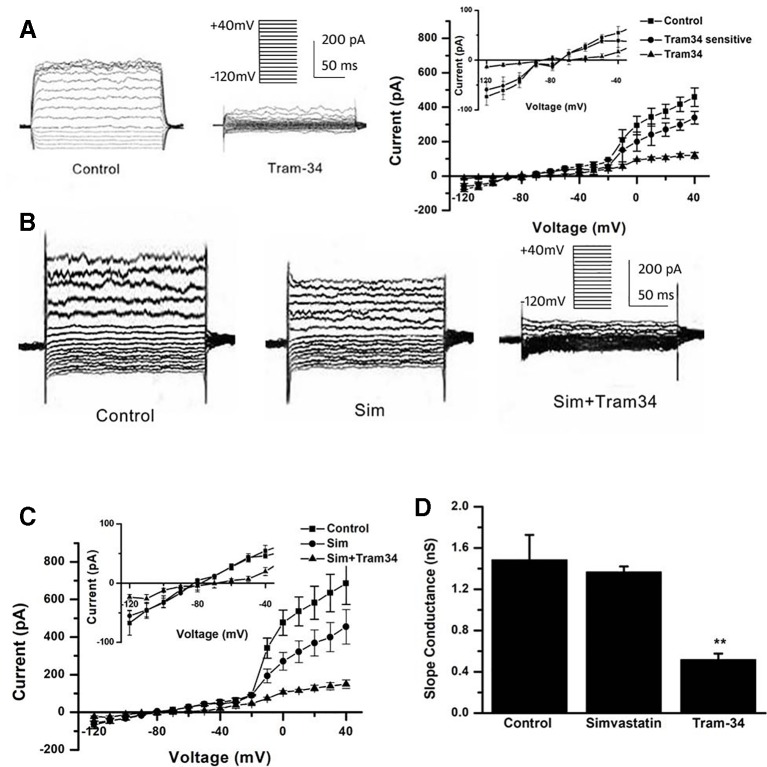
Effects of simvastatin on KCa3.1 current intensity change in THP-1 cells measured by whole-cell clamp patch. (A) The THP-1 cells were held at −40mV and received the test potentials from −120 to +40 mV; the KCa3.1 currents were detected by using an electrode with 1 µM free Ca2+. The currents were blocked by 1 μM Tram-34. (B) The representative current traces of KCa3.1. Simvastatin treatment had no significant effect on the current intensity of KCa3.1. (C) Average current density-voltage relationships before and after application of 10 µM simvastatin and 1 µM Tram-34 was indicated (n = 4 for each group). (D) The slope conductance between −120 mV and −40 mV was measured by fitting the curve with linear equation. Data was summarized from 4 THP-1 cells, **P < 0.01, vs. normal controls.